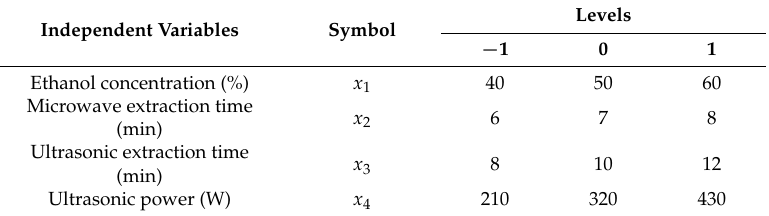
Table 3. Independent variables and their levels in the response surface